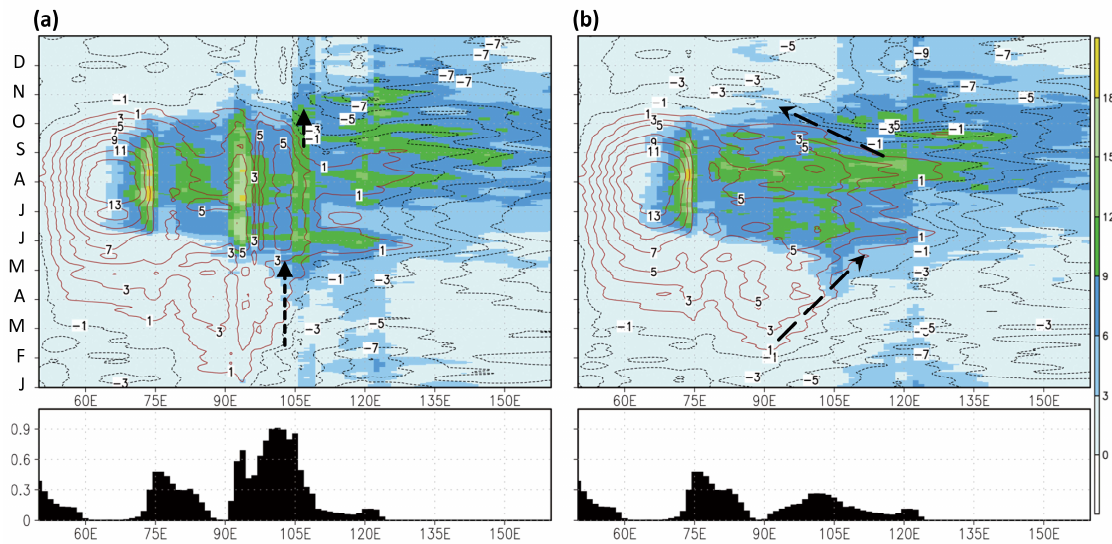
Figure 7. Same as Figure 6, except for ( a ) AA simulation; and ( b ) IP0 simulation. Sharp wind changes over the Indochina Peninsula are marked by vectors.